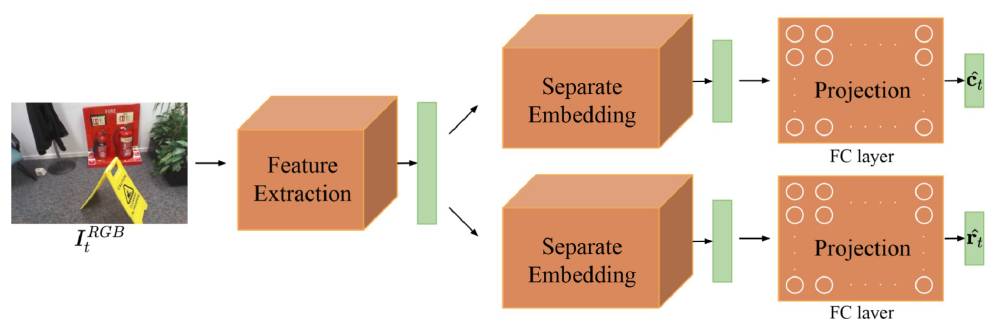
Figure 1. Network architecture of APR methods. Orange rectangles or blocks represent layers with learnable parameters, and green rectangles denote the output of each